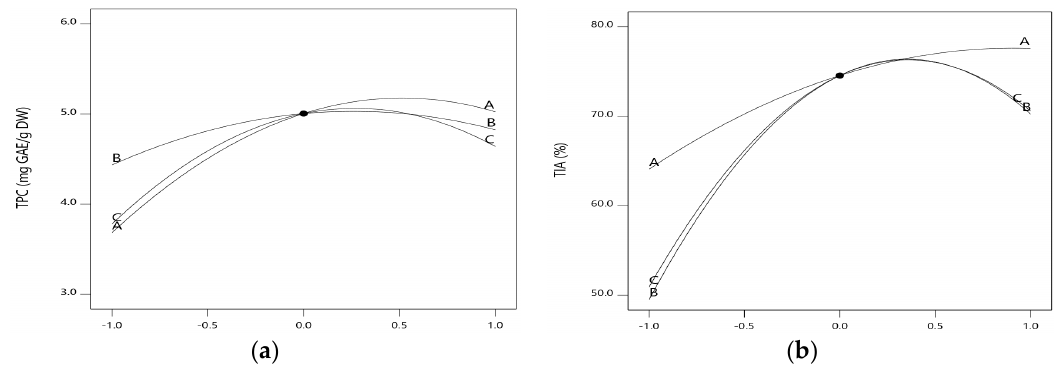
Figure 1. ( a ) Perturbation plot of actual TPC of mealworm extracts as a function of extraction temperature, extraction time, and ethanol concentration; ( b ) Perturbation plot of actual TIA of mealworm extracts as a function of extraction temperature, extraction time, and ethanol concentration.